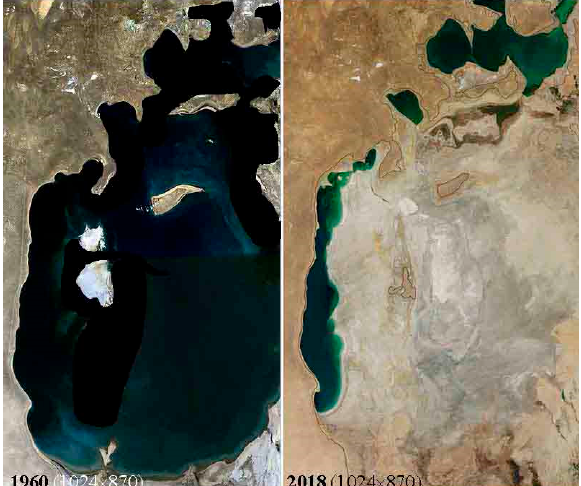
Figure 1. Aral Sea evolution history. Landsat satellite imagery mosaics showing visible changes of the Aral Sea. Source: USGS/NASA; visualization by UNEP/GRID-Sioux Falls. https://na.unep.net/geas/getUNEPPageWithArticleIDScript.php?article_id=108 Table 1. Hydrological history of the Aral Sea Basin (CAWATER Database of the Aral Sea. www.cawater-info.net > aral > data > index_e [12,17]).